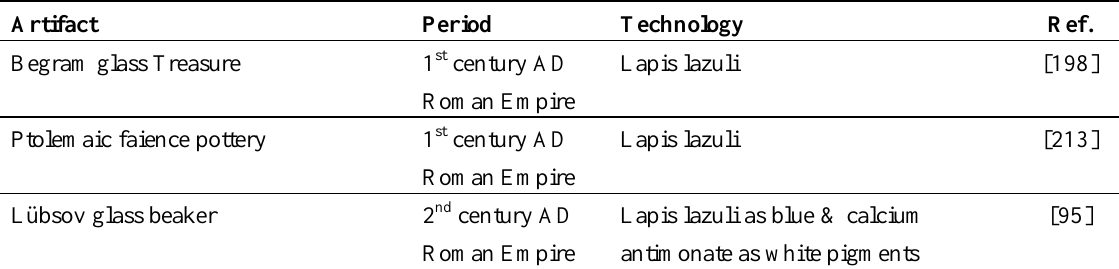
Table 7. Technologies used to obtain blue and white hues as evidenced by Raman